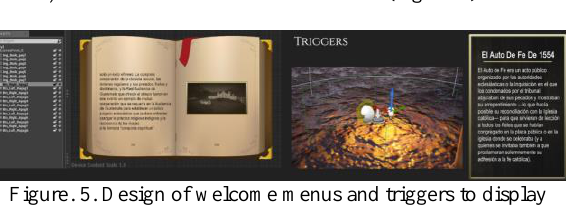
Figure 7. Pre-awareness room for the project.